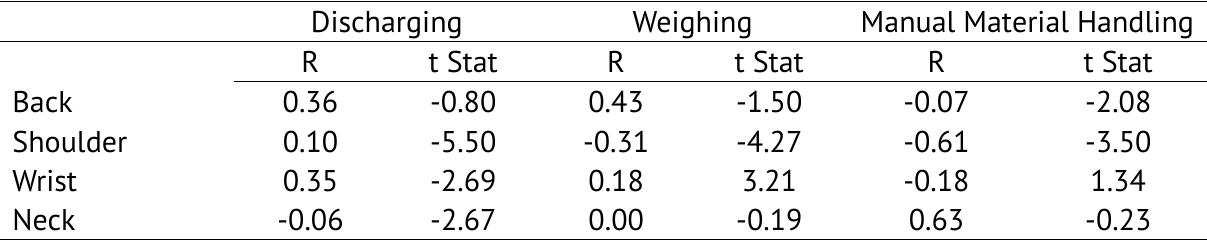
Pearson correlation between REBA and QEC evaluation of operations in small-scale